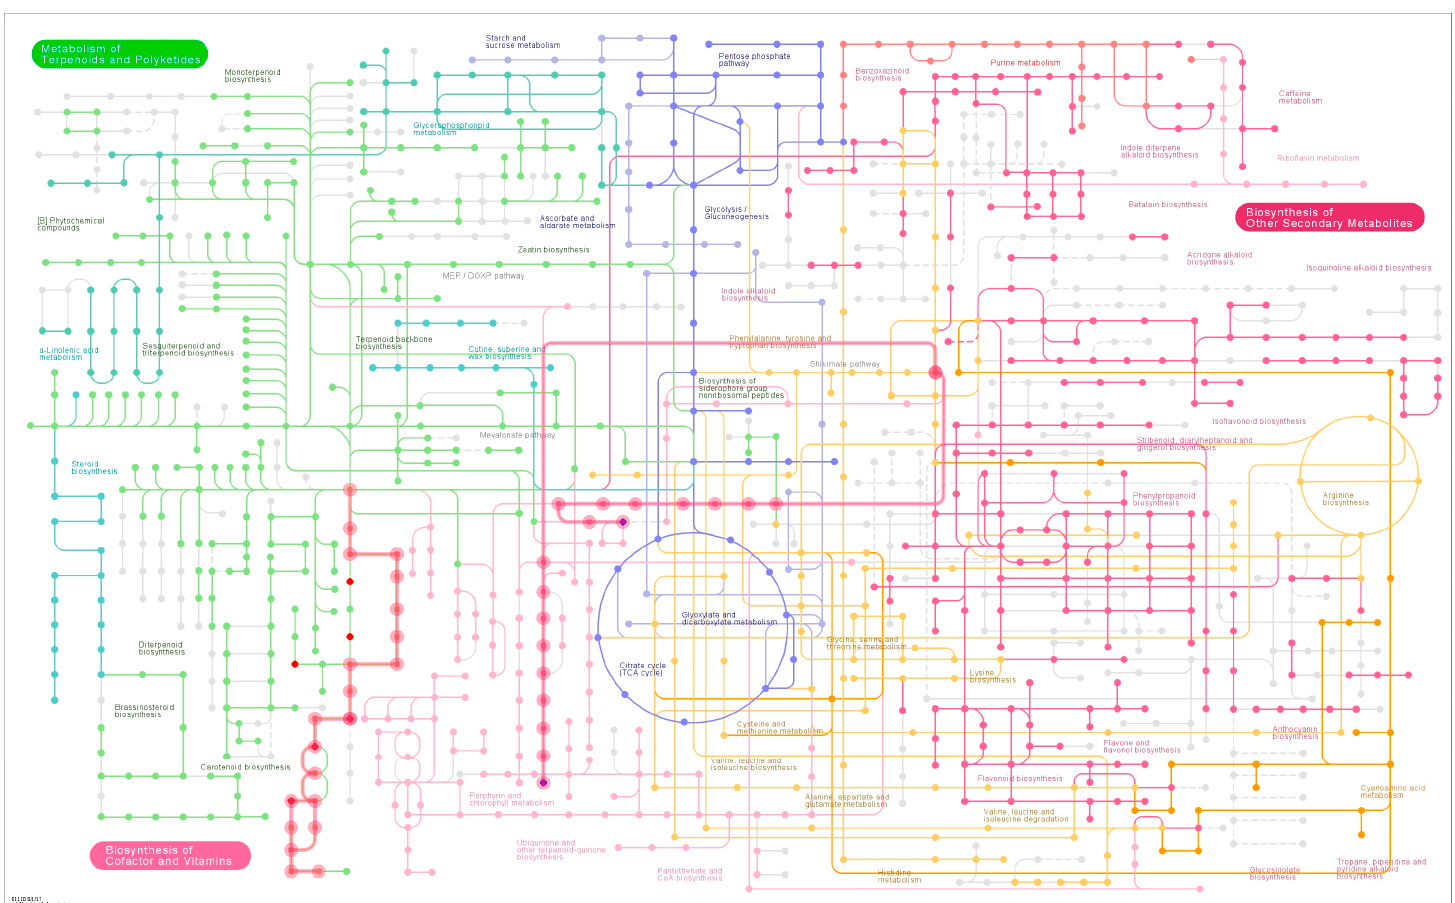
Figure A1. Biosynthesis of secondary metabolites (carotenoids and isoprenoid quinones) by Asaia lannensis and Asaia bogorensis. Bolded pink lines with red markers are carotenoids. Bolded pink lines with purple markers are ubiquinone-10 and menaquinone.